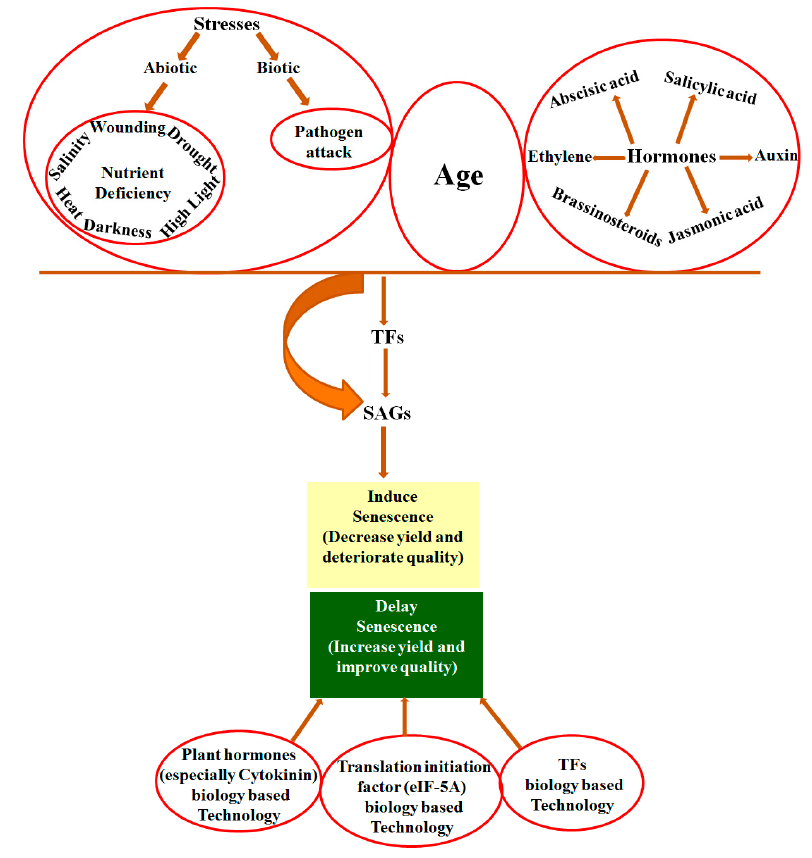
Figure 1. Transcriptional regulation and manipulation of leaf senescence.